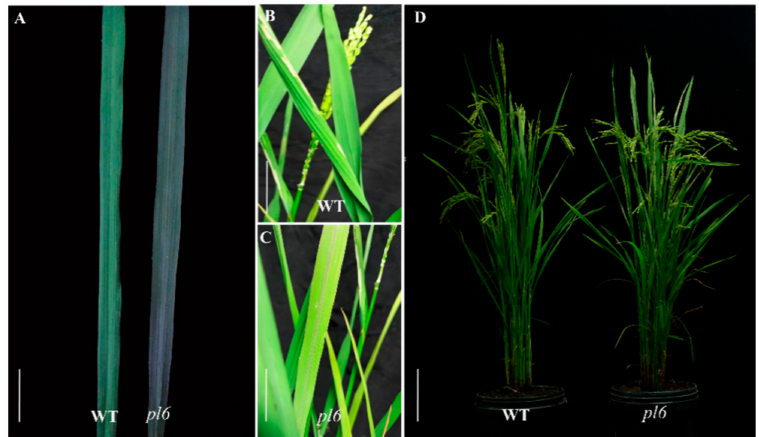
Figure 1. Morphological features of the wild type (WT) and pl6 mutant at di ff erent growth stages. ( A ) The leaf at the tillering stage, bar = 2 cm; ( B , C ) The leaves of WT and pl6 mutant at late Heading stage, respectively; bar = 5 cm; ( D ) The plant at late grain filling stage, Bar = 10